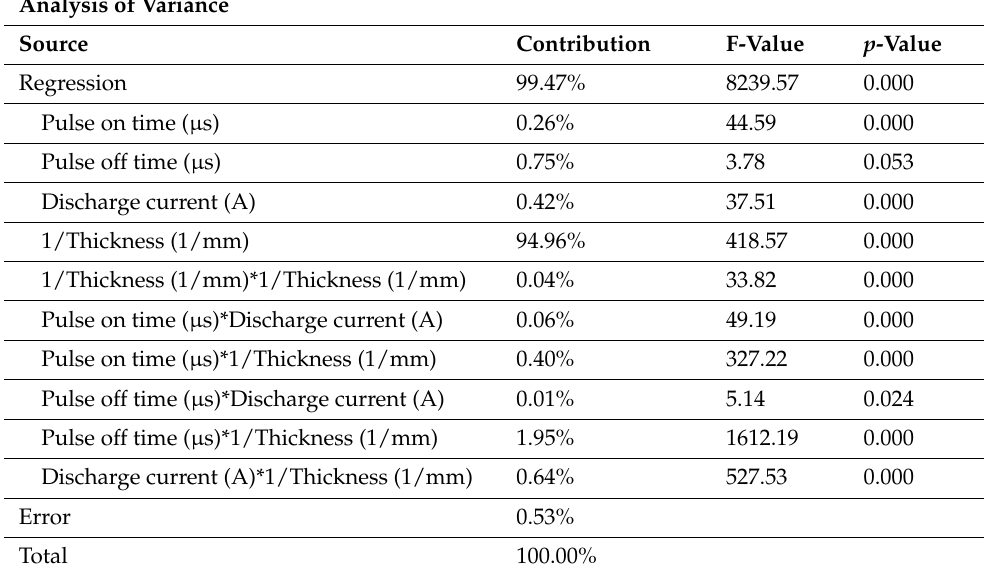
Table 3. Regression model of cutting speed, including the expressed percentage contribution of individual